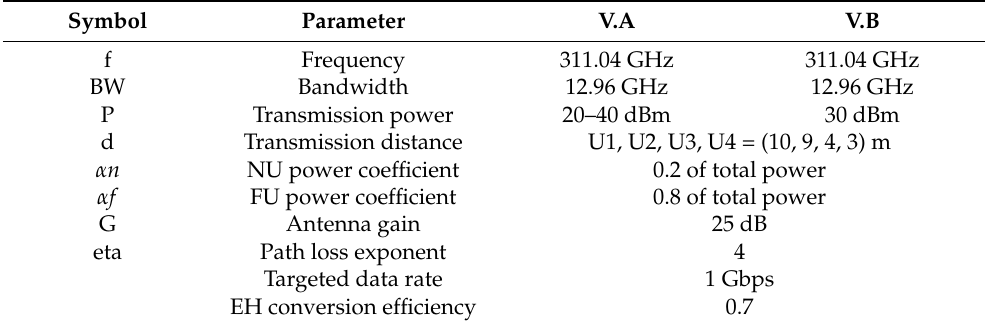
Table 2. Simulation parameters.